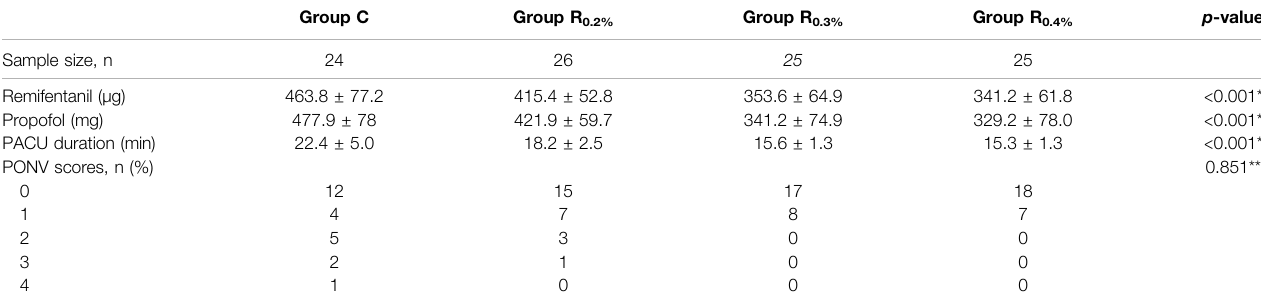
TABLE 4 | Intraoperative anesthetic dosage, postoperative analgesic, and recovery of four groups ( (cid:1) x ± SD). Group C Group R 0.2% Group R 0.3% Group R 0.4% p -value Sample size,